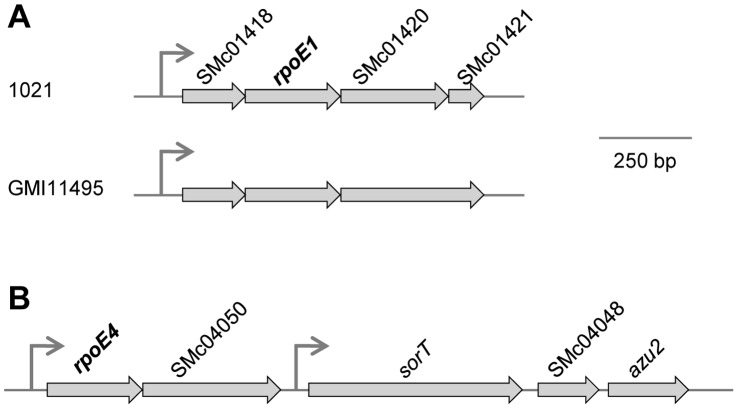
Schematic representation of the rpoE1 (A) and rpoE4 (B) chromosomal regions of S. meliloti.Grey-colored arrows represent open reading frames. Promoters mapped in the present study (Fig. 4) are indicated. In A is shown a comparison of the rpoE1 regions in the reference strain 1021 and in strain GMI11495 used in this study (see text).